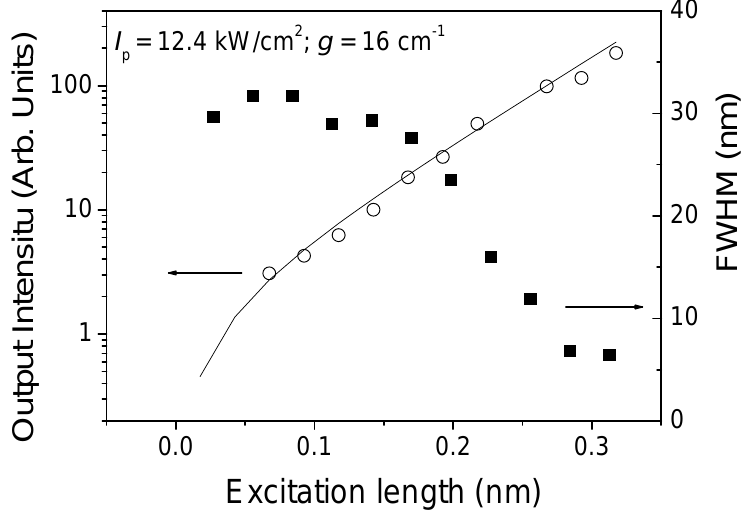
Figure 3. FWHM (right axis, solid square) and emission intensity at  = 416 nm (left axis, open circles) as a function of excitation length, at a pump intensity of 12.4 kW/cm 2 for a 10 wt% TPD-doped PS film. The solid line is the fit to data using Equation